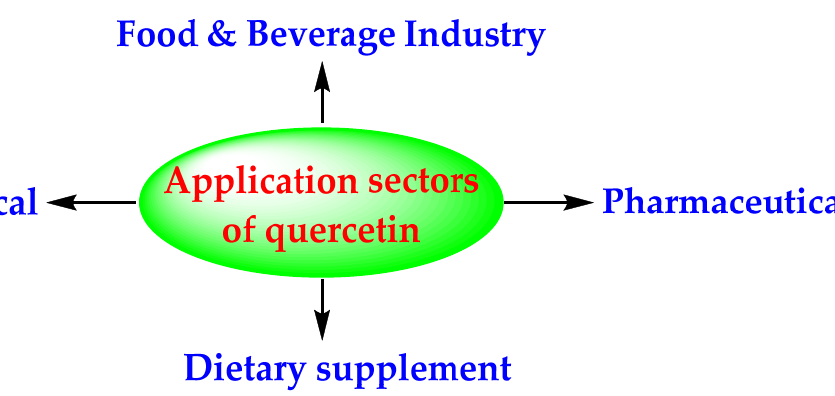
Figure 2. Application segments of quercetin according to end use [24].